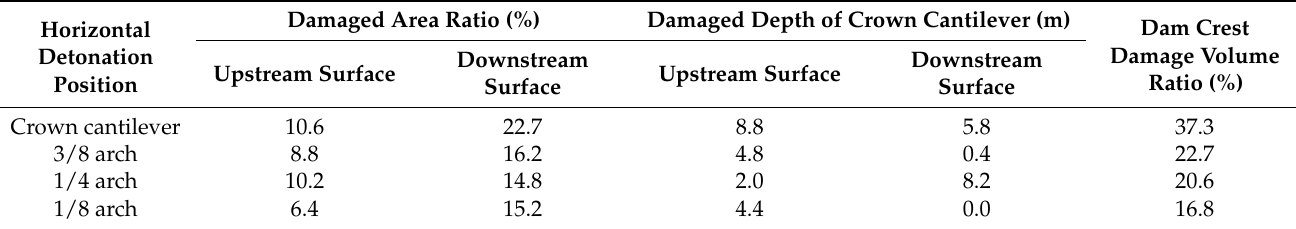
Table 5. Arch dam body damage at various horizontal blast positions.